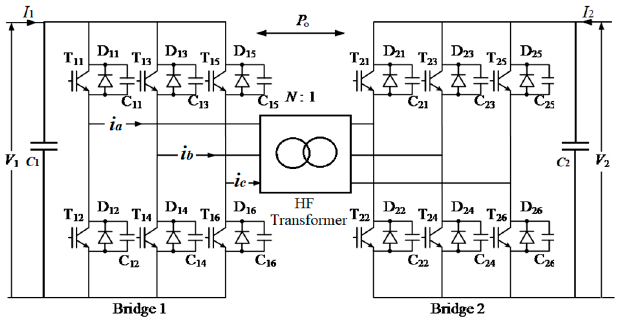
Figure 1. A bidirectional isolated DC-DC converter topology.